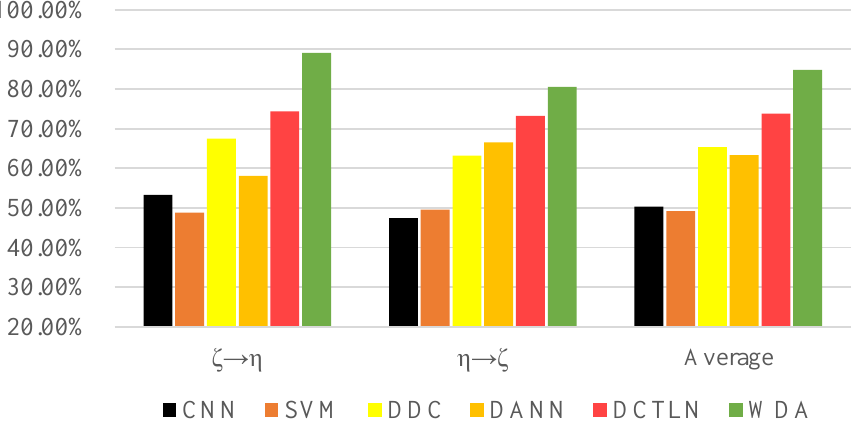
Figure 12. Accuracies of methods under different transfer conditions.